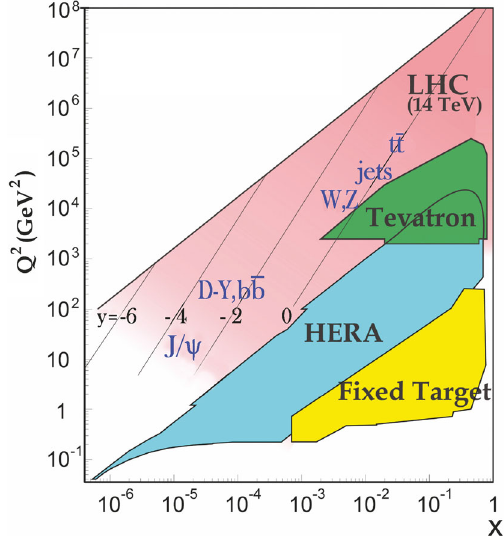
Fig. 10 The kinematic plane investigated by various collider and fixed target experiments in terms of Bjorken- x and momentum transfer Q 2 . Figure from Ref.